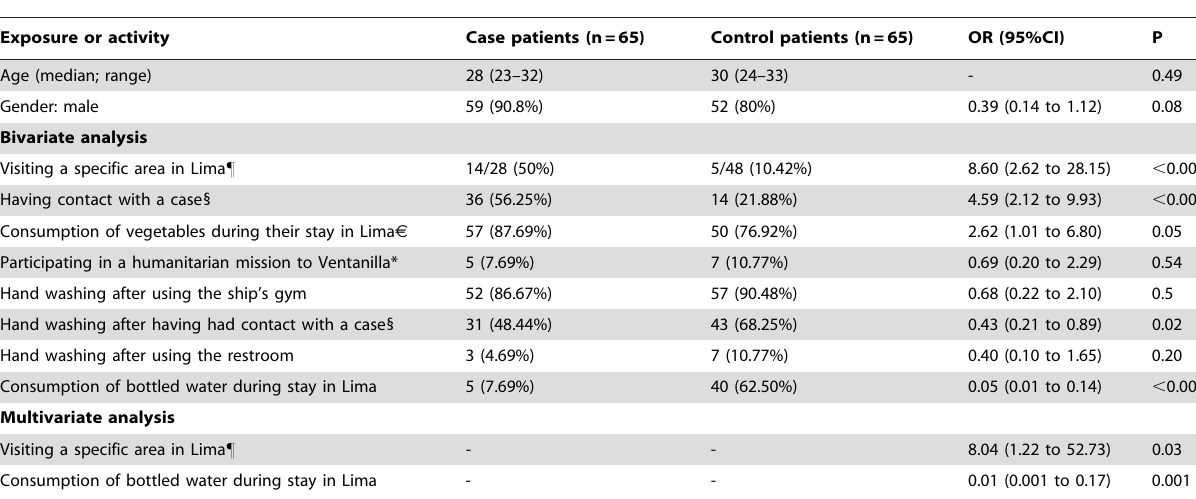
Table 1. Exposures and activities associated with acute